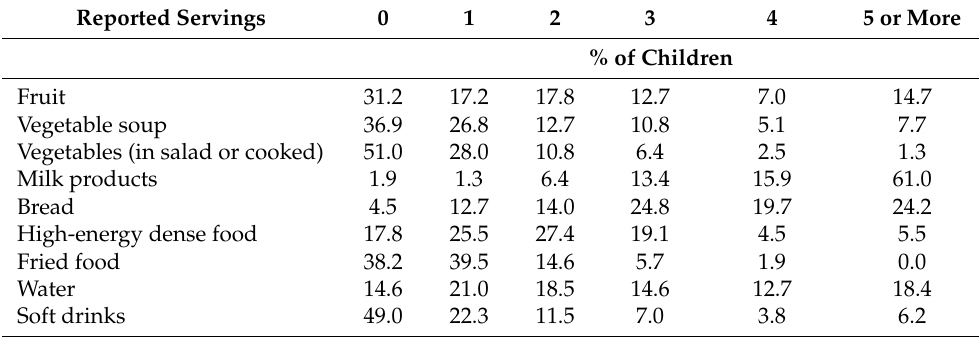
Table 2. Baseline eating behaviour of children in a 3-day period ( n =